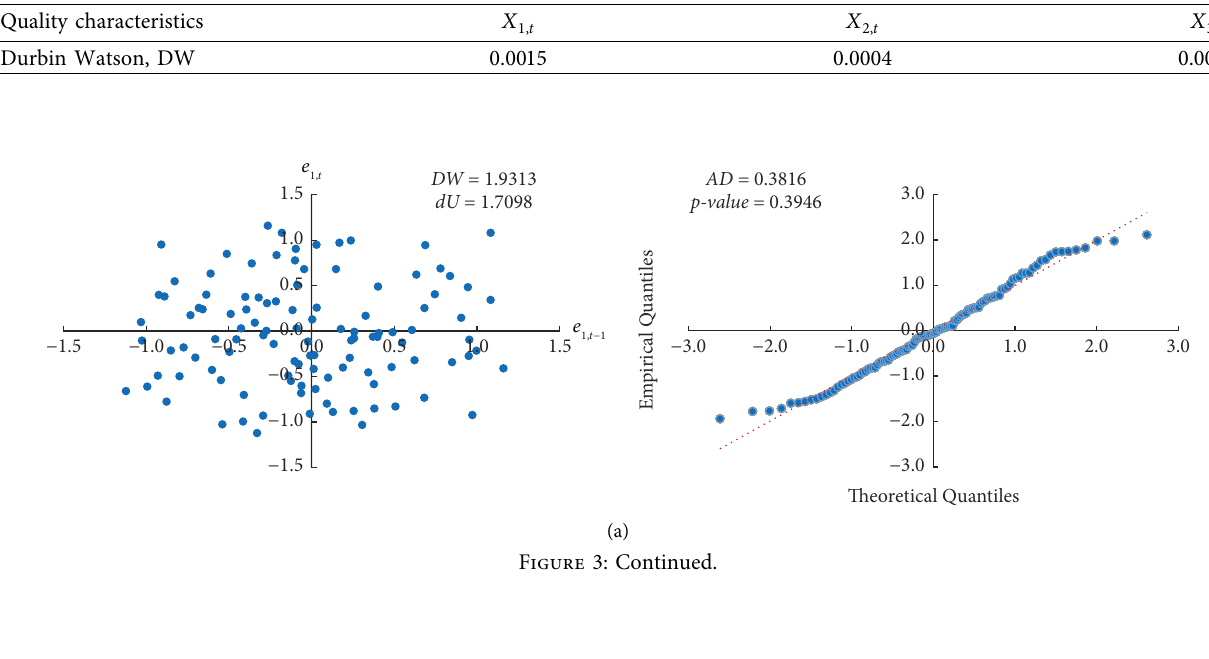
Table 2: Durbin Watson test for X